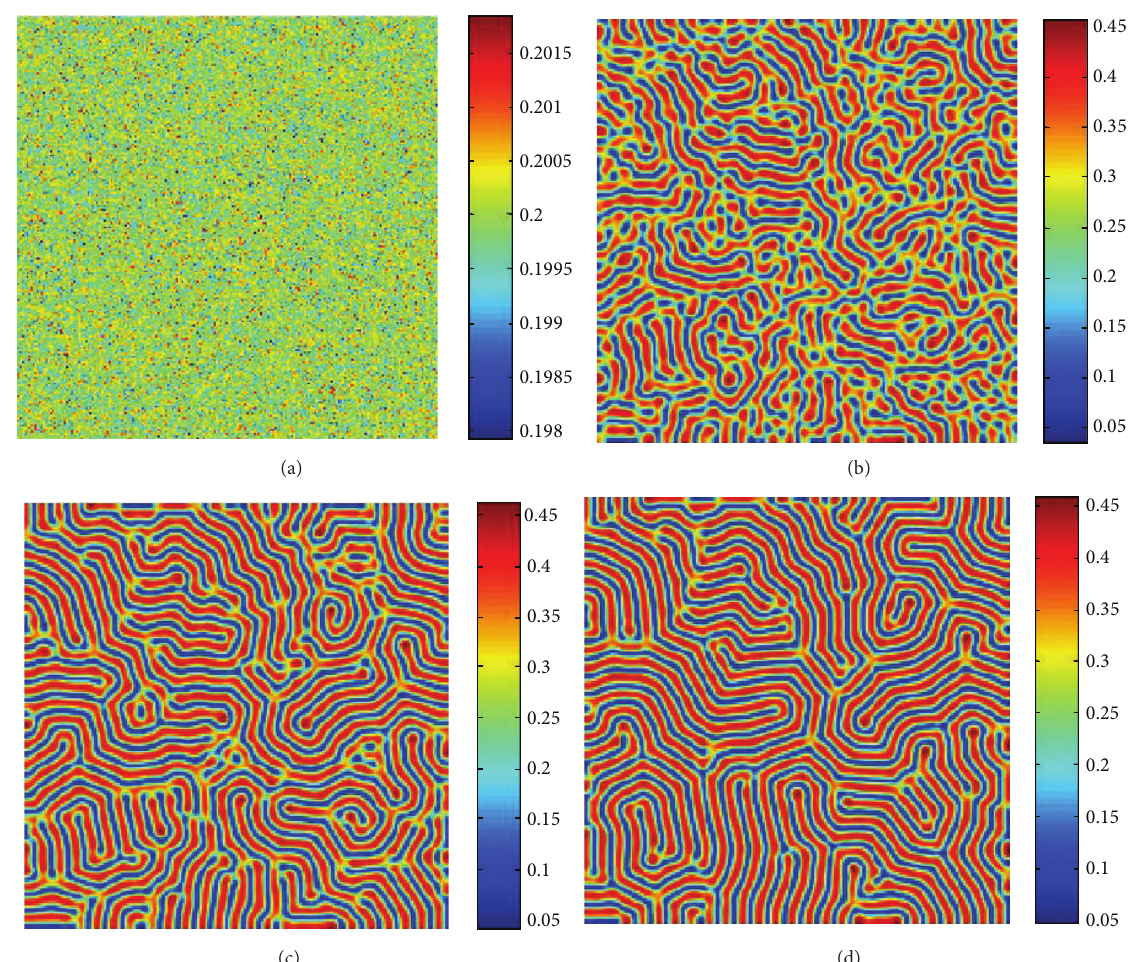
Figure 4: Snapshots of the time evolution of the prey at different instants with 𝛾 = 1 , 𝑑 = 0.05 , 𝑠 = 0.5 , 𝜏 = 0.3 , 𝐷 𝑢 = 0.25 , and 𝐷 V = 3 , which are in the Turing space. (a) 0 iteration; (b) 10000 iterations; (c) 50000 iterations; and (d) 300000